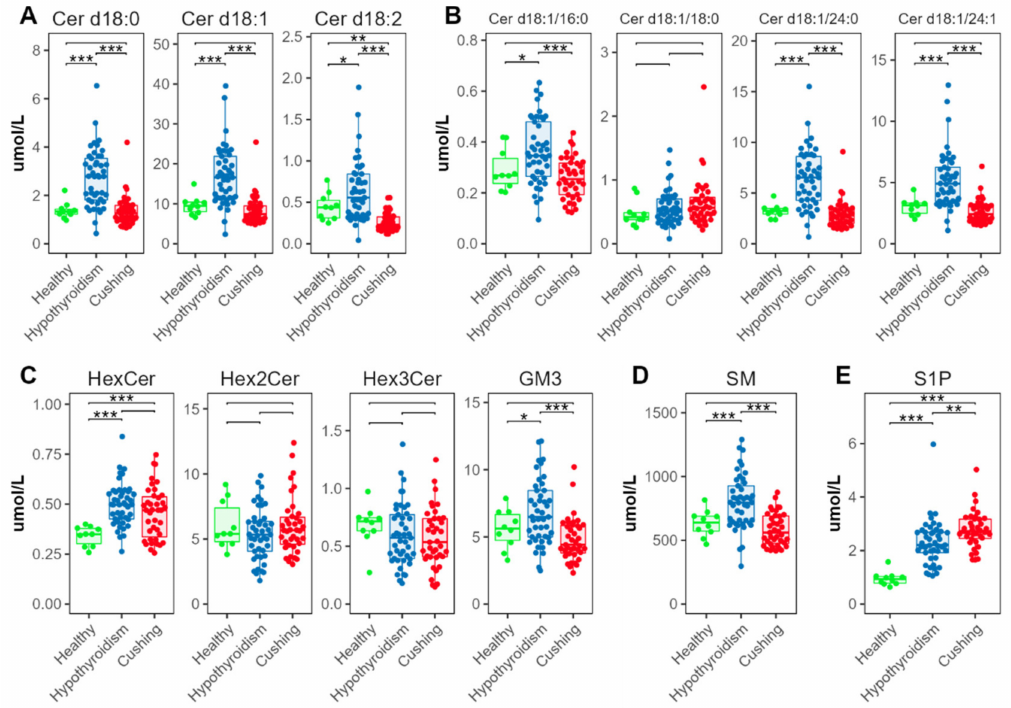
Figure 6. Abundance of species from sphingolipid classes. ( A ) Total ceramide, ( B ) individual ceramide species, ( C ) glycosphingolipids, ( D ) sphingomyelins, ( E ) sphingosine 1-phosphates. Levels of statistical significance between two groups calculated by two-tailed Welch’s t -tests are indicated